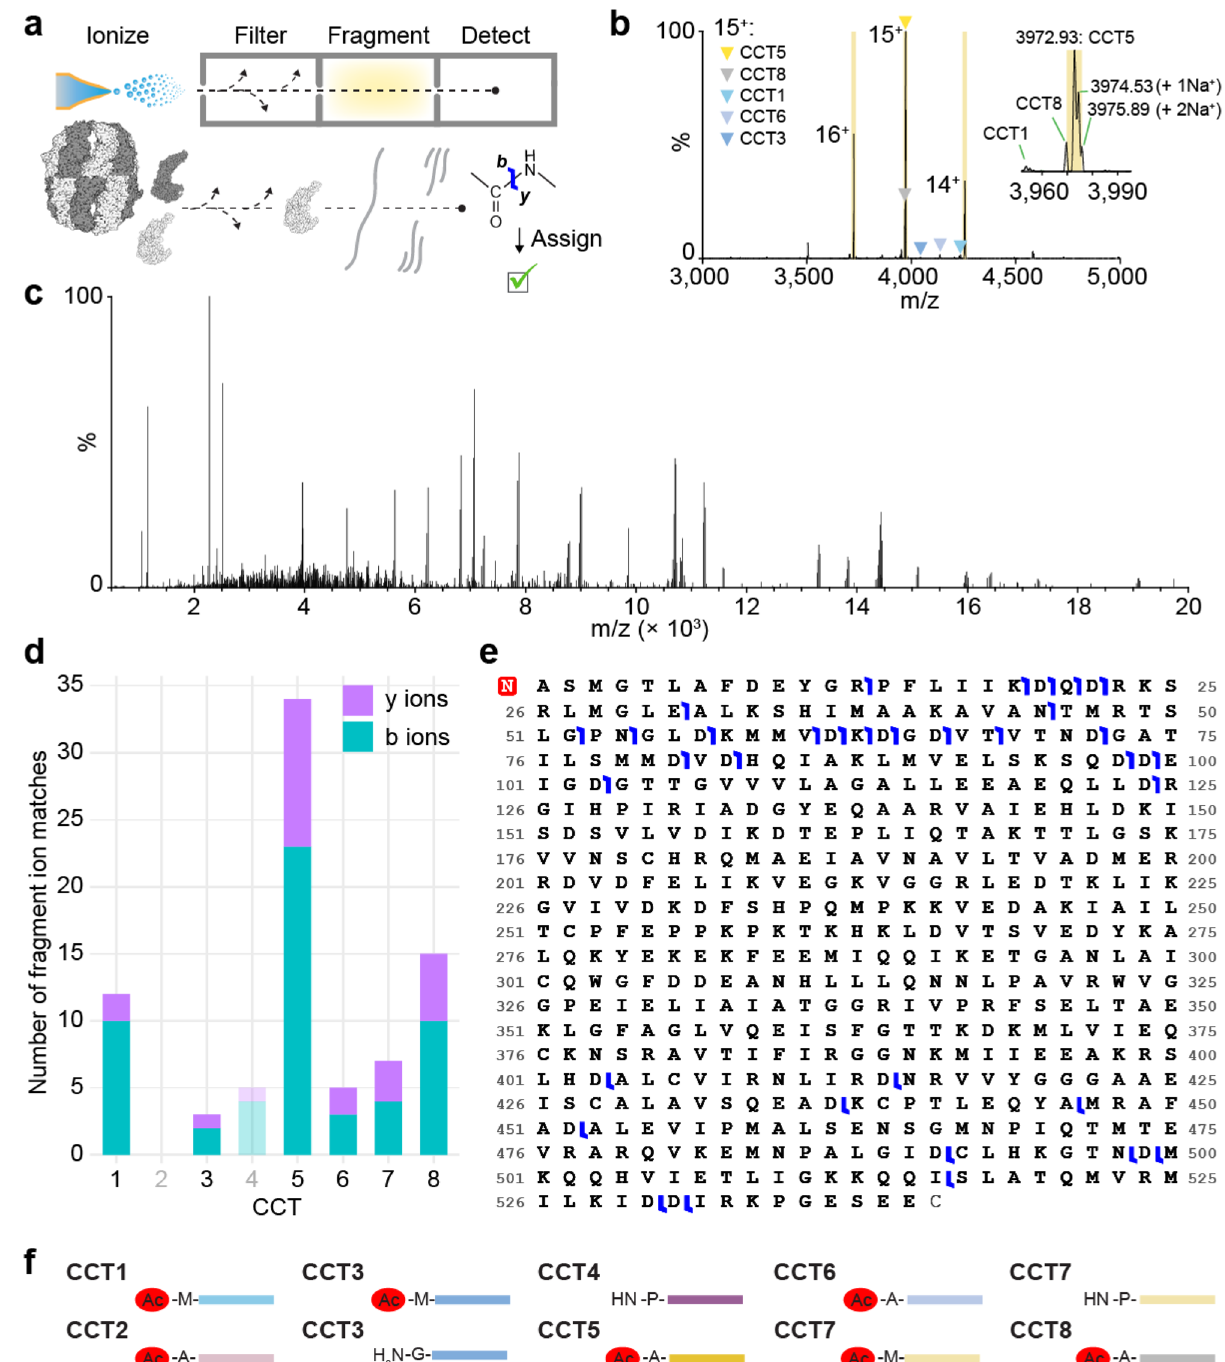
Figure 3. CCT5 is N-terminally processed by methionine excision and acetylation. ( a ) Schematic of the top-down MS experiment. The chaperonin is color-coded as though subunit identities are unknown. ( b ) Monomer region of the native mass spectrum of a hTRiC variant lacking subunits CCT2 and CCT4, containing predominantly CCT5 and trace amounts of other subunits (colored triangles). Each highlighted peak was fragmented. The inset is a magnified view of the most abundant charge state, 15 + , showing that the resolution is high enough to distinguish sodium adducts. The CCT8 15 + peak is just 3 m/z to the left of the peak of interest. ( c ) Deisotoped peptide spectrum resulting from fragmentation of the 15 + peak in b . ( d ) Numbers of fragment ion matches from all highlighted peaks in b to sequences of all CCT subunits, divided into b- and y-ions. CCT2 and CCT4 are faded because they were not present in the sample, and can therefore serve as negative controls for the expected number of false positives. ( e ) Primary sequence of human CCT5 without the initiator methionine. Blue marks indicate at least one reported peptide mass (in data from all three highlighted peaks in b ) supporting an N- or C-terminal ion cleaved at the given site. The red N at the N-terminus designates acetylation. ( f ) Measured and inferred N-terminal states of post-translationally processed recombinant hTRiC subunits expressed in insect cells. Red ovals denote